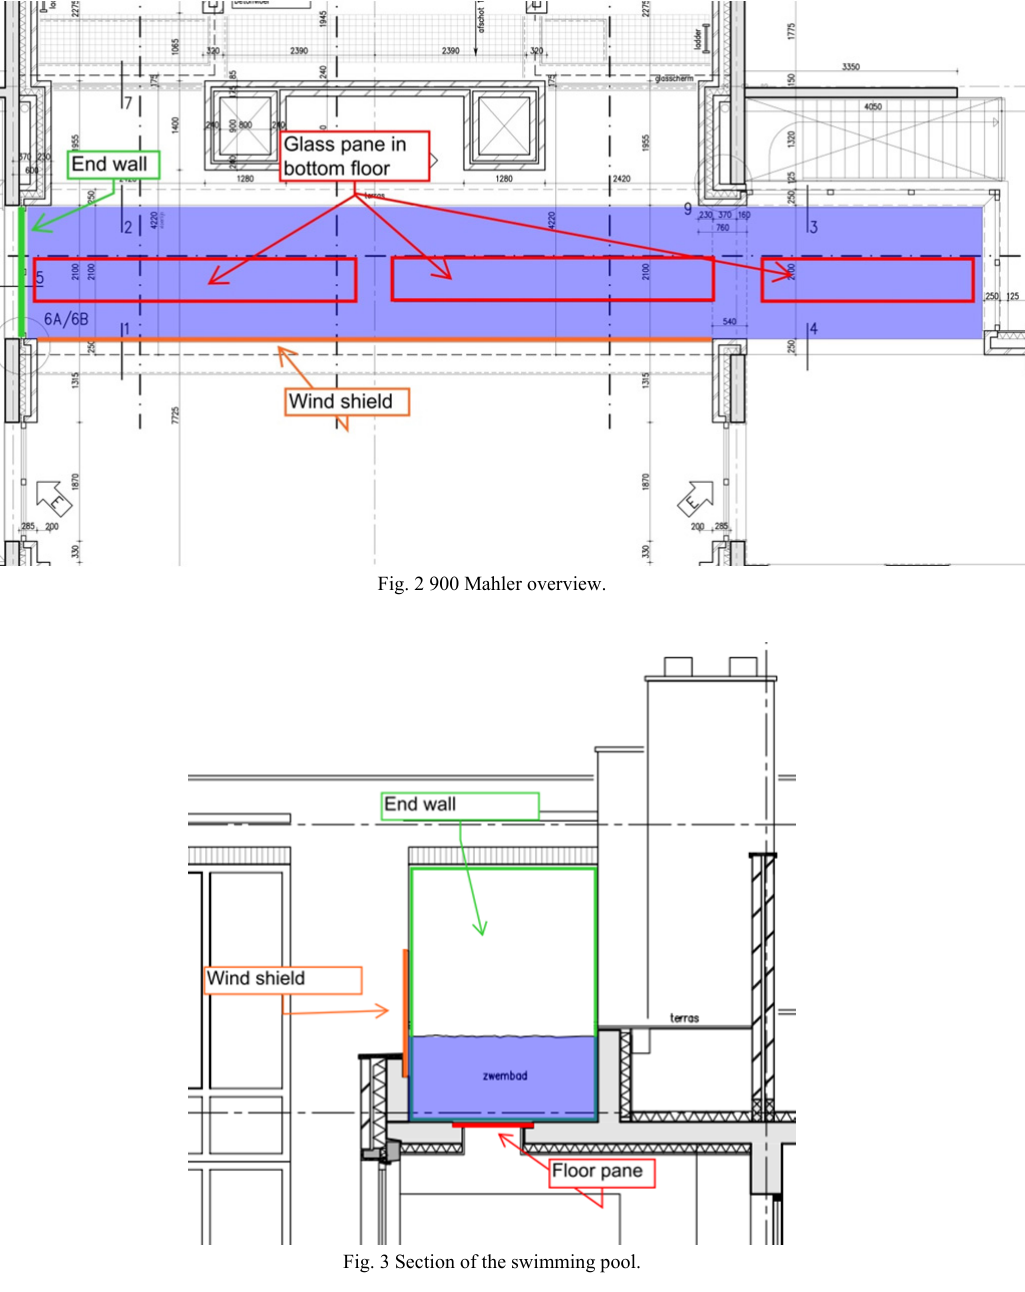
Fig. 3 Section of the swimming pool.